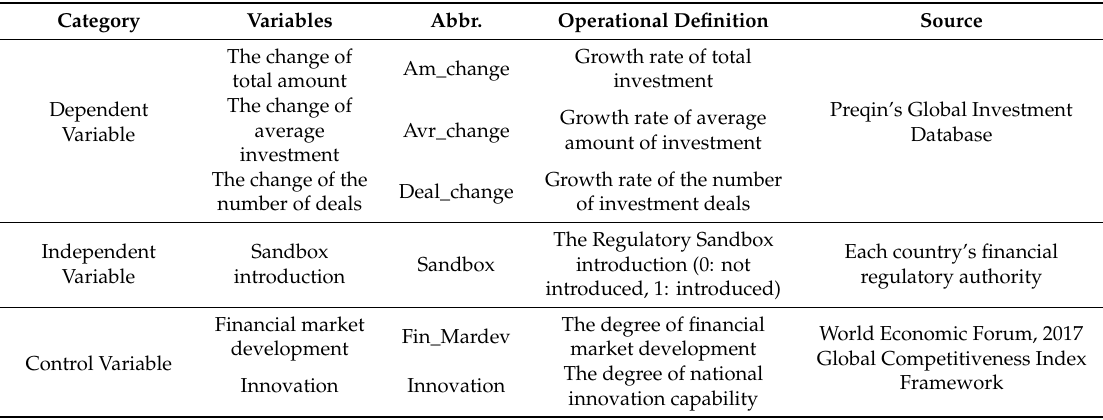
Table 6. Operational definitions of